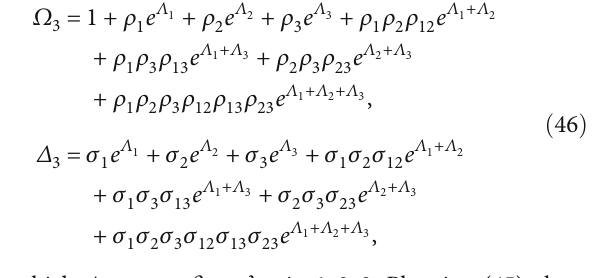
= 2, ρ = 3, β = 2 : 5, β = 3 : 4, γ = 0 : 75, γ 1 2 1 2 1